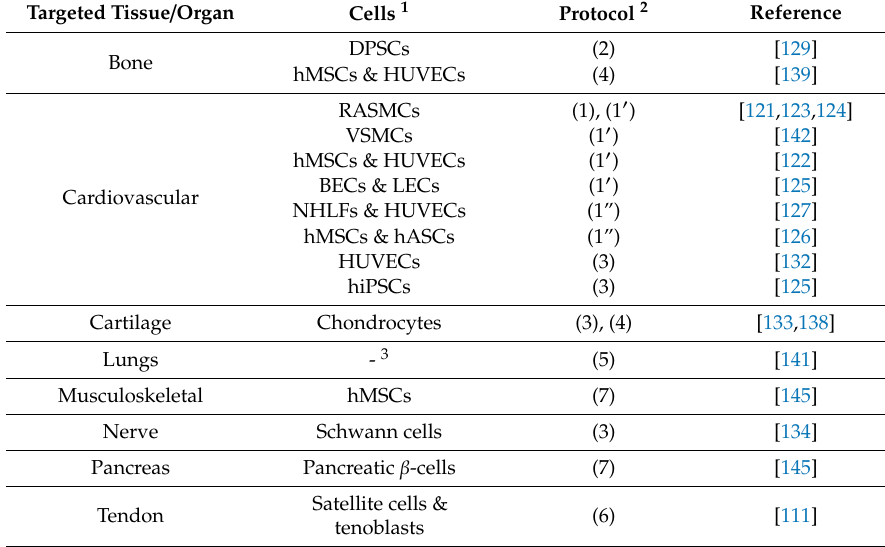
Table 1. Main biomedical applications of mixed type I collagen-fibrin